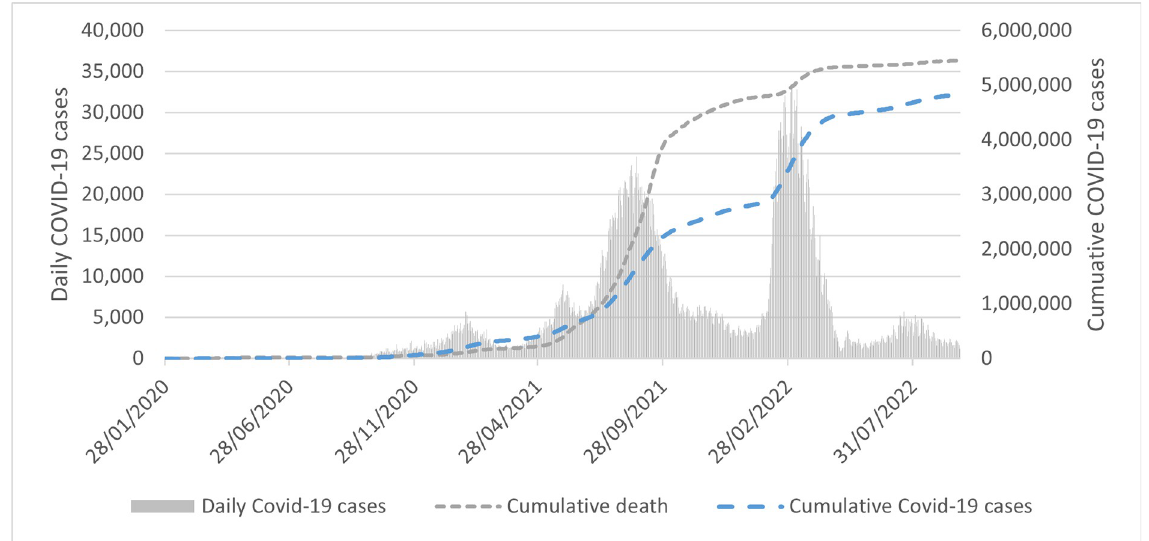
Fig 2. The cumulative COVID-19 cases, cumulative death and daily COVID-19 cases in Malaysia from January 28, 2020 to September 26, 2022. Source: